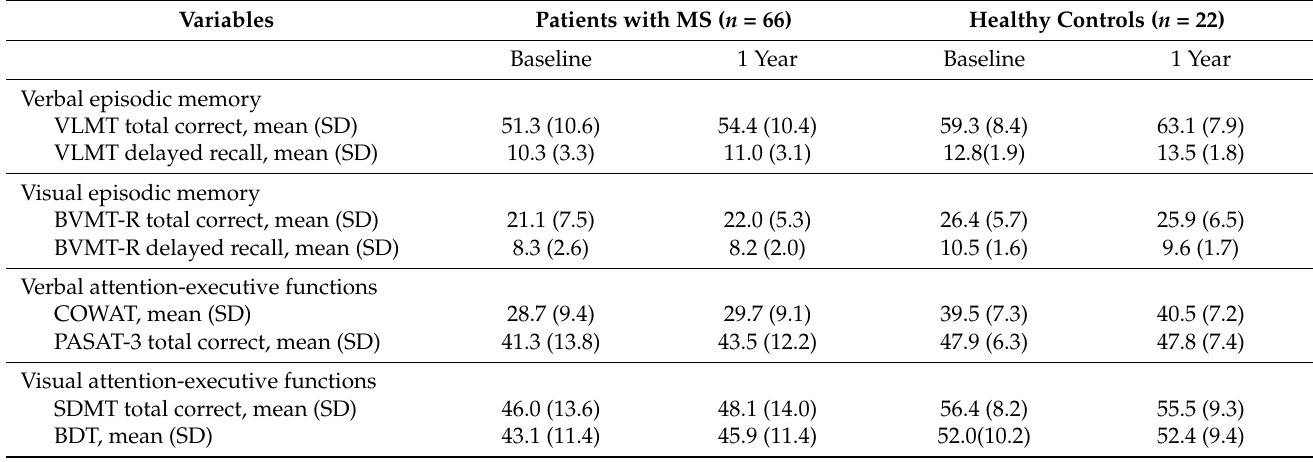
Table 2. Baseline and one year follow up cognitive tests results of MS patients and healthy